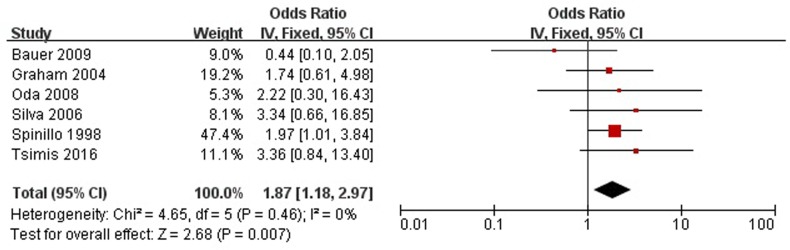
Fixed-effect model forest plot for the odds ratio of the association between acidemia and PVL.The pooled OR of acidemia is presented as a solid diamond at the bottom of the forest plot, the width of which represents the 95% CI.